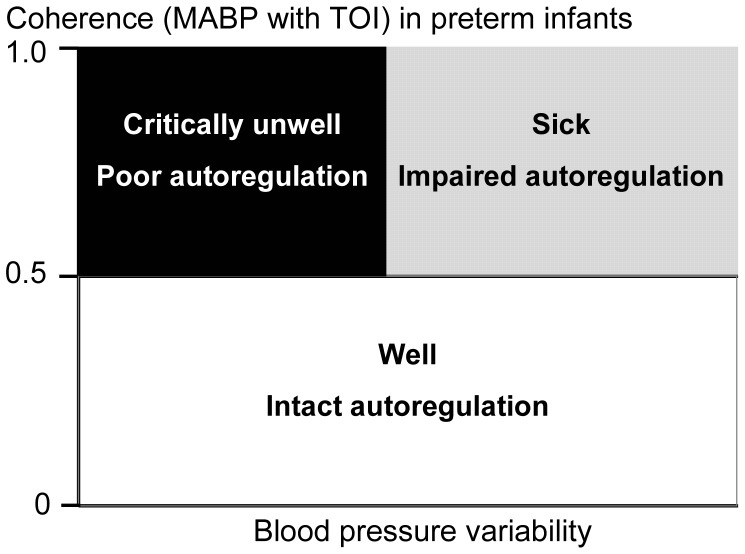
Schematic model of cerebral autoregulation versus clinical condition of preterm infants.Well infants with intact autoregulation have Coh<0.5 over a wide range of BPV. Sicker infants with impaired autoregulation have Coh>0.5 when BPV is high and exceeds autoregulatory capacity. Sickest infants with absent autoregulation have Coh>0.5 even with relatively low BPV.